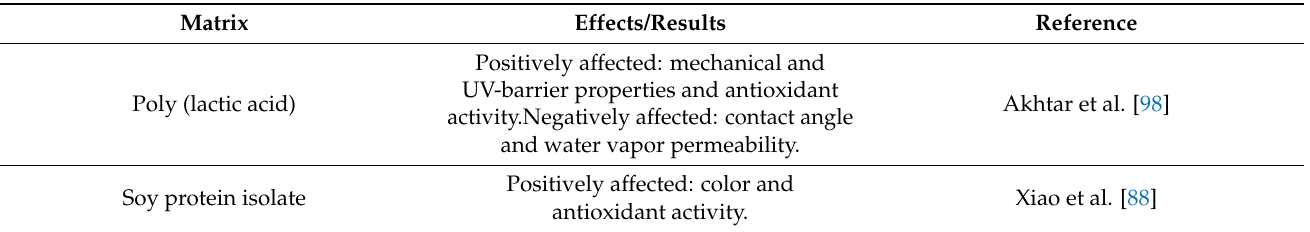
Table 1. Primary effects of curcumin incorporation on the properties of edible bioactive biopolymeric films.